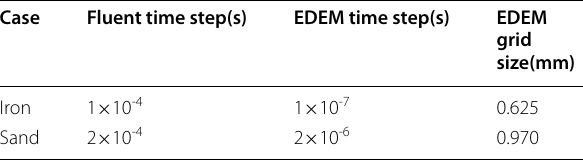
Table 2 Coupling parameters of Fluent and